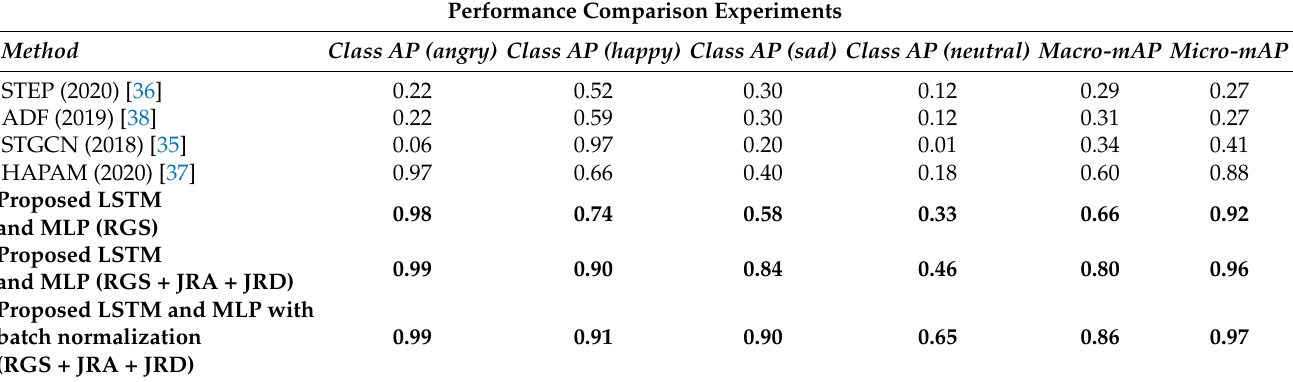
Table 7. Performance comparison of the recent methods with the proposed bi-modular sequential neural network.